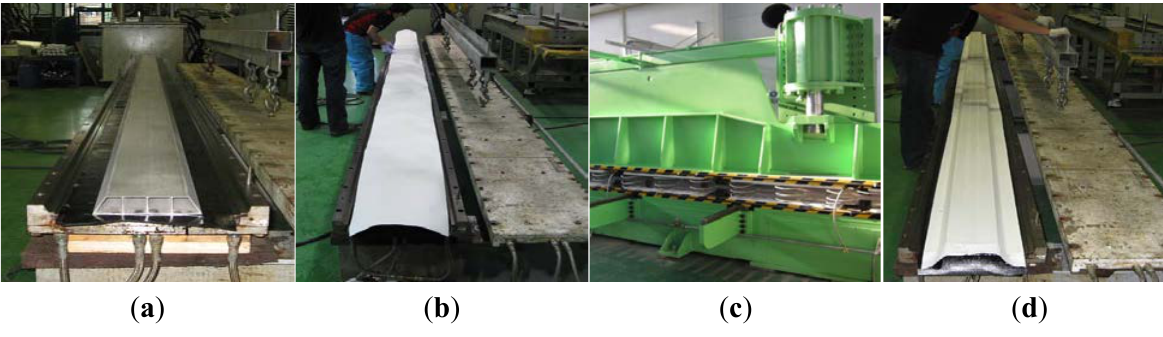
Figure 2. Manufacturing process of ( a ) lower laminated fiber-glass and aluminum beam; ( b ) upper laminated fiber-glass and protection film; ( c ) hot- press process; and ( d ) demold.